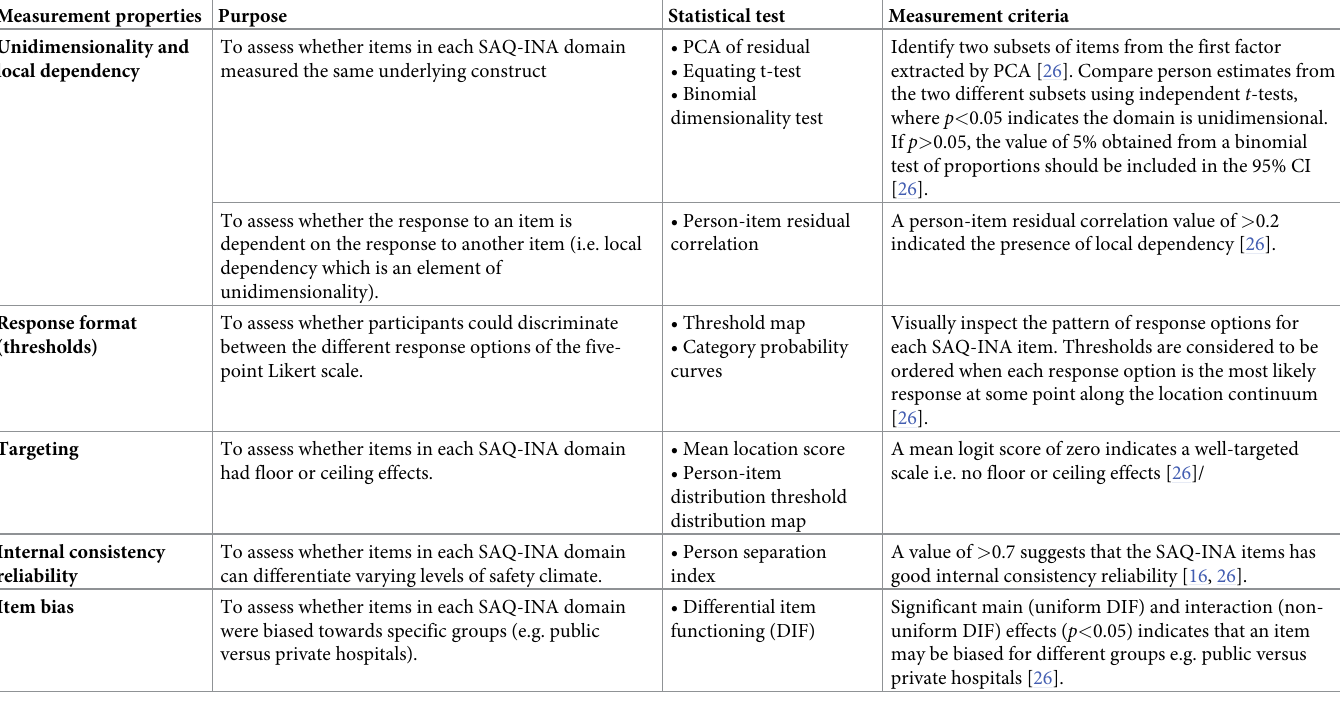
Table 1. Measurement properties and criteria assessed in the Rasch